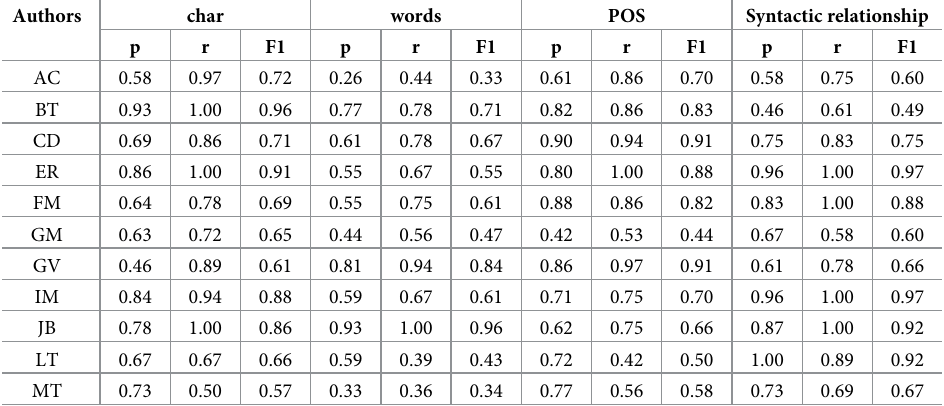
Table 13. Precision, recall and F1 in ALL